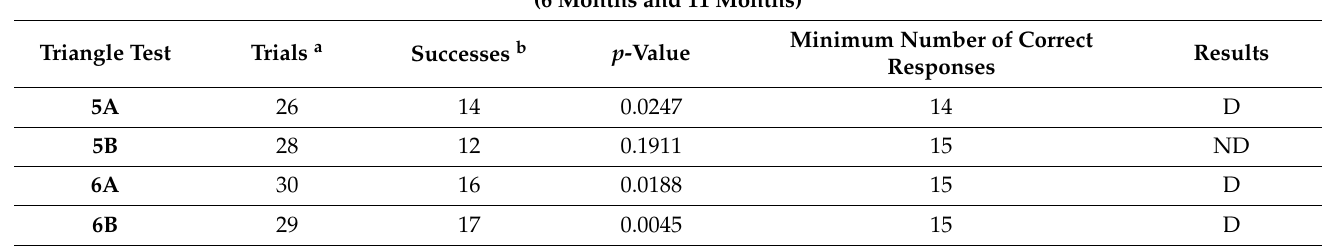
Table 3. Results from the Triangle Olfactometric Test II with α ≤ 0.05. Triangle Test II: Fresh and Aged Beer without Differentiate Types of